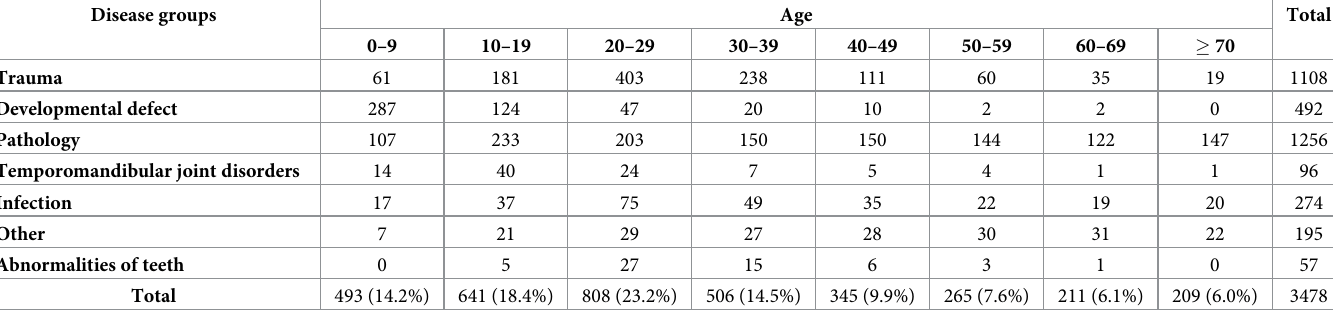
Table 2. Distribution of oral and maxillofacial diseases by age (years). Disease